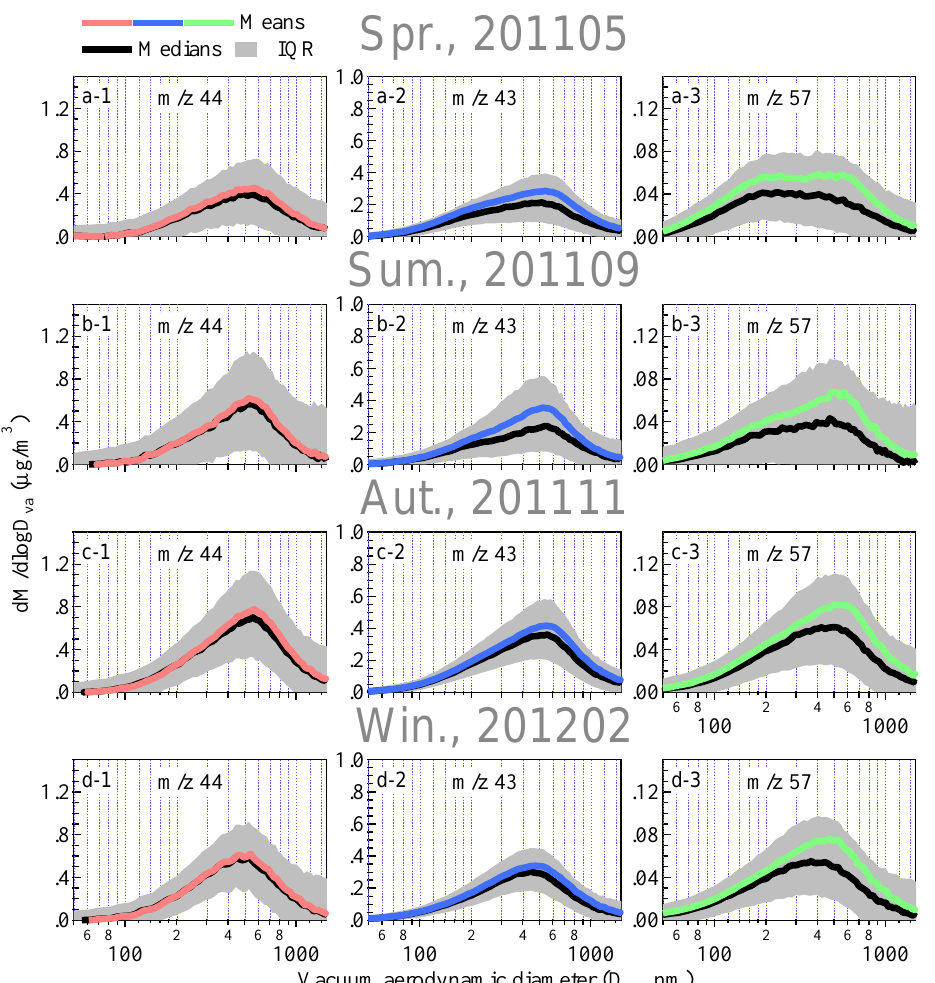
Figure 4. Size distributions of ions with m/z values of 44, 43, and 57 in organics in the 4 months. The red, blue, and green lines are the means; the black lines are the medians; and the grey areas are the interquartile ranges (IQRs).